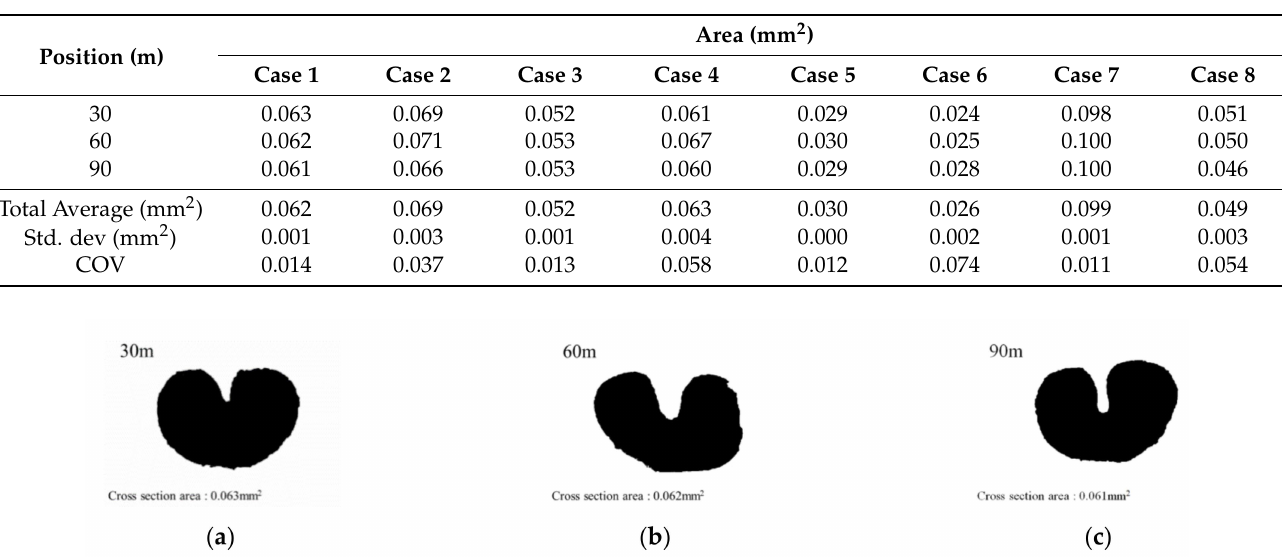
Table 2. Distribution of the cross-sectional area for CNT/PVDF fiber conditions.